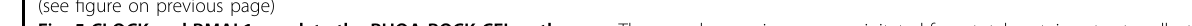
Fig. 5 CLOCK and BMAL1 regulate the RHOA-ROCK-CFL pathway. a The complex was immunoprecipitated from total protein extracts collected from HeLa cells transfected with corresponding plasmids. The proteins were then analyzed by Co-IP with antibodies against RhoGDI. b The TNT ® Quick Coupled Transcription/Translation System was used here for protein (BMAL1, CLOCK, RHOA, and RHOGDI) synthesis. The synthesized proteins were then analyzed by Co-IP with corresponding antibodies. c The RHOA distribution was affected by BMAL1 or CLOCK, as detected by a cytosolic/ membrane fractionation assay in HeLa cells. * p < 0.05; ** p < 0.01, n.s. no signi fi cant. d HeLa cells transfected with the indicated vectors were harvested and analyzed using a 96-well ROCK Activity Assay Kit. The activity levels were normalized to those in the control, which was given an arbitrary value of 1 ** p < 0.01. e CLOCK and BMAL1 can promote the activation of RHOA and the expression of RHOA and other proteins involved in the RHOA-ROCK- CFL pathway. Activated RHOA was pulled down using a GST-Rhotekin-Rho-binding domain (RBD) fusion protein. f Immuno fl uorescent staining of p- co fi lin (Ser-3) in HeLa cells transfected with BMAL1 + , CLOCK + , shBMAL1, and shCLOCK. Scale bar, 5 µm. g HeLa cells transfected with the indicated plasmids were treated with 1 μ g/ml CT04 (RHOA inhibitor) for 2 h and Y27632 (ROCK inhibitor) for 20h before whole-cell lysates were extracted and analyzed. Statistical results of the p-co fi lin protein level are shown to the right * p < 0.05; ** p < 0.01, n.s. no signi fi